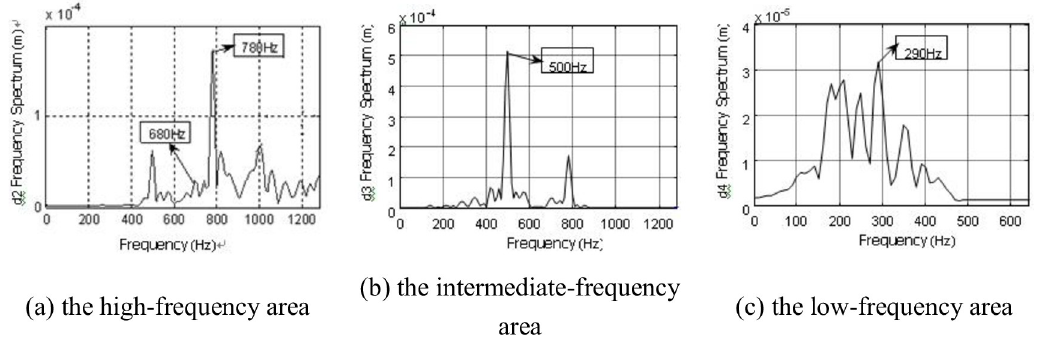
Fig 16. Frequency spectrum of Y direction displacement response restructuring signal under F =